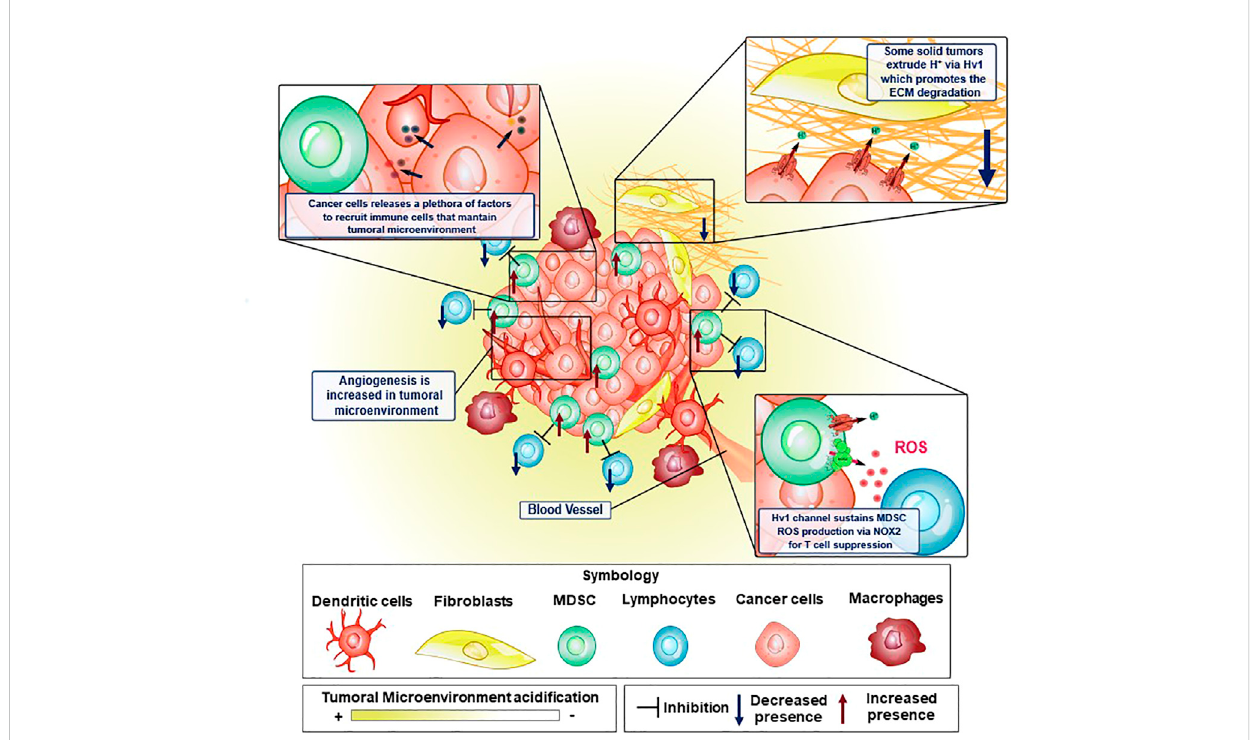
FIGURE 3 Elements ofthetumormicroenvironmentandhowHv1channeliscrucialtosustain somemalignantfeaturesincancer. Tumoralmicroenvironment isconstituted byseveral cellular elements, where immune system cells arekeyto maintainthetumoral microenvironment conditions to promotecancer cell development. In some of these cellular elements, the Hv1 channel has been shown to possess an important role. Proton extrusion through Hv1 promotes local acidi fi cation of the TME, which in turn, has been shown to induce the activation of extracellular matrix degrading proteases favoring cancer cell migration. On the other hand, MDSC are strongly immunosuppressive, preventing and interfering with tumor elimination by T-cells. This immunosuppression is led by ROS production via NOX2 enzymatic complex, a process that is sustained thanks to the functional coupling between NOX2 and Hv1 channel. Moreover, cancer cells release tumoral factors that maintain the features of the tumoral microenvironment. Examples of these are VEGF, HIF, GM-CSF, TNF- α , IL-12, IL-10, TGF- β . GM-CSF recruits MDSC to the tumoral microenvironment and maintains its strongly immunosuppressive